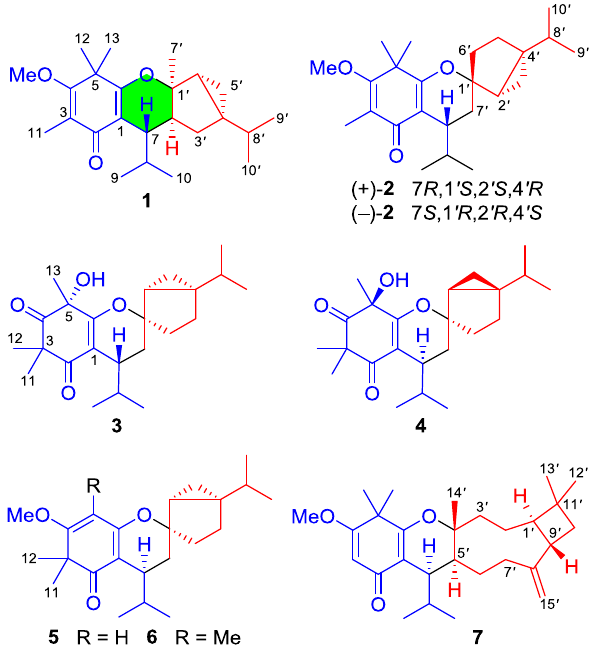
Fig. 1 Chemical structures of 1 – 7